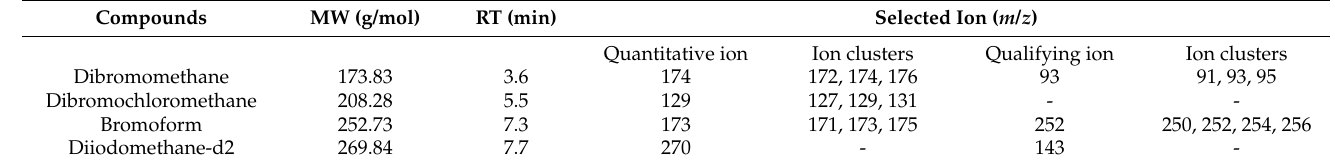
Table 3. Quantitative and qualifying ions, retention time (RT) and molecular weight (MW) of halomethanes. Compounds MW (g/mol) RT